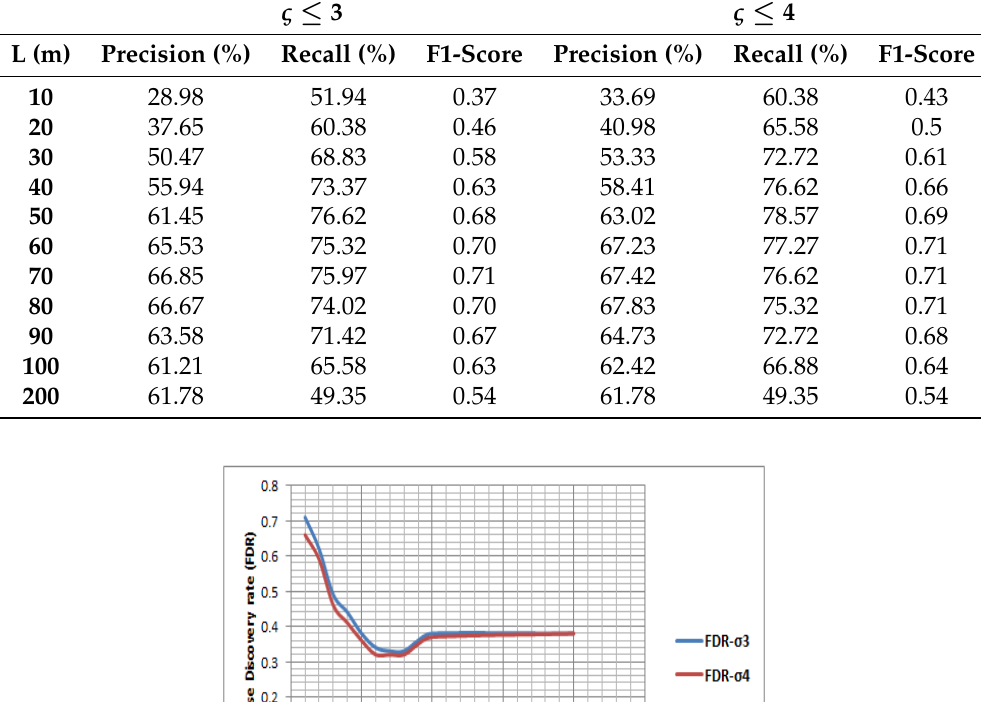
Table 10. Accuracy measure of trip detection by walking-based approach.